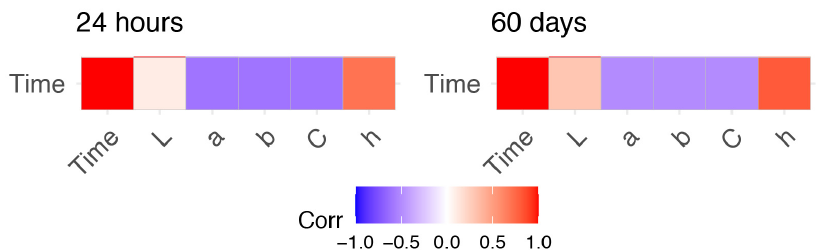
Figure 1. Heatmap of the level of correlation of the five analysed colorimetric coordinates with time since deposition. Positive and negative correlations are depicted in red and blue color schemes, respectively. Higher correlations are shown by dark tonalities, whereas weak correlations are represented by light colors.